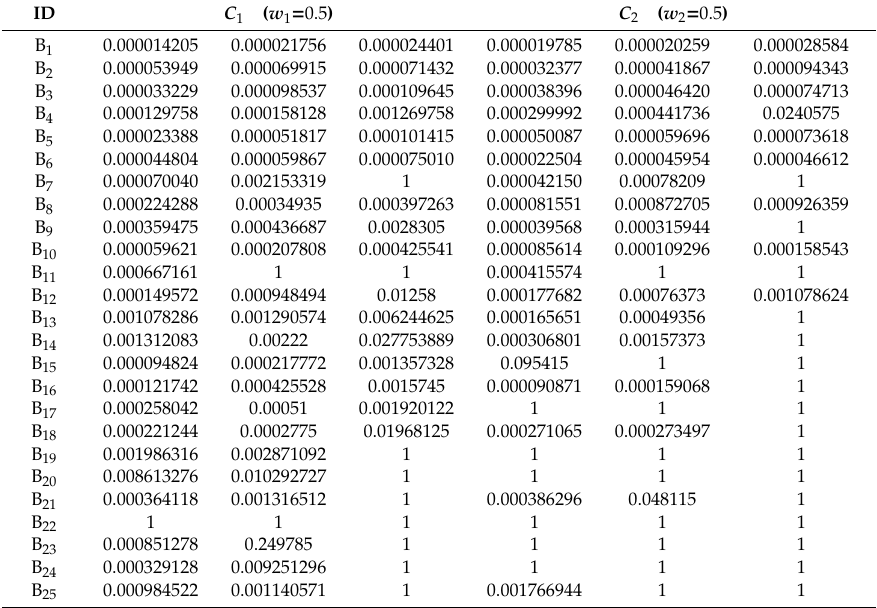
Table A3. Normalised and weighted fuzzy matrix referred to the February 2012 measurement.